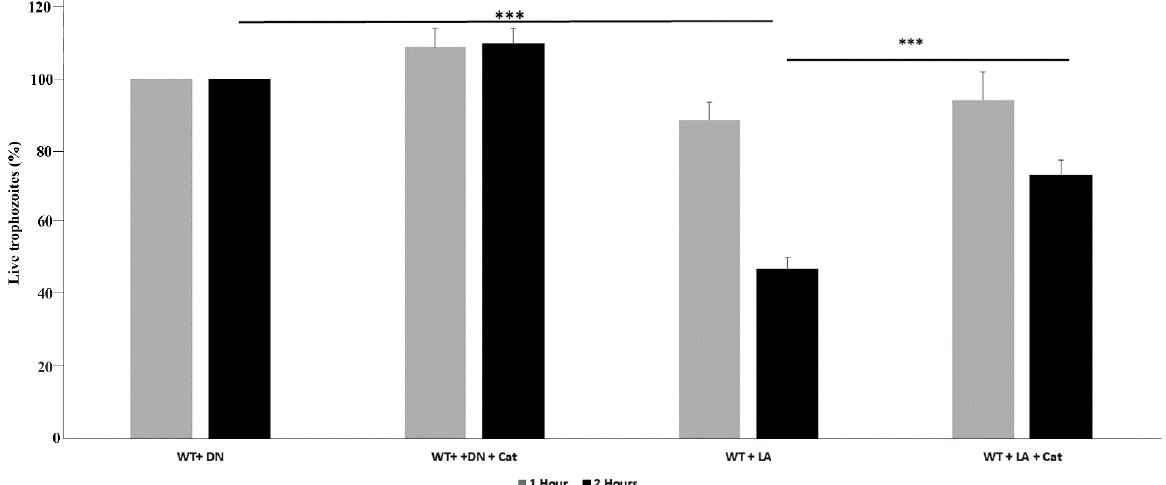
Figure 1. Viability assay of E. histolytica trophozoites. Note: E. histolytica trophozoites (WT) were incubated with live L. acidophilus (LA) or with heat-killed L. acidophilus (DN), with/without catalase (Cat) (50 μ g/mL) for 60 and 120 min at 37 °C. The data represent two independent experiments performed in triplicate. *** p value < 0.001 by an unpaired Student’s t -test.